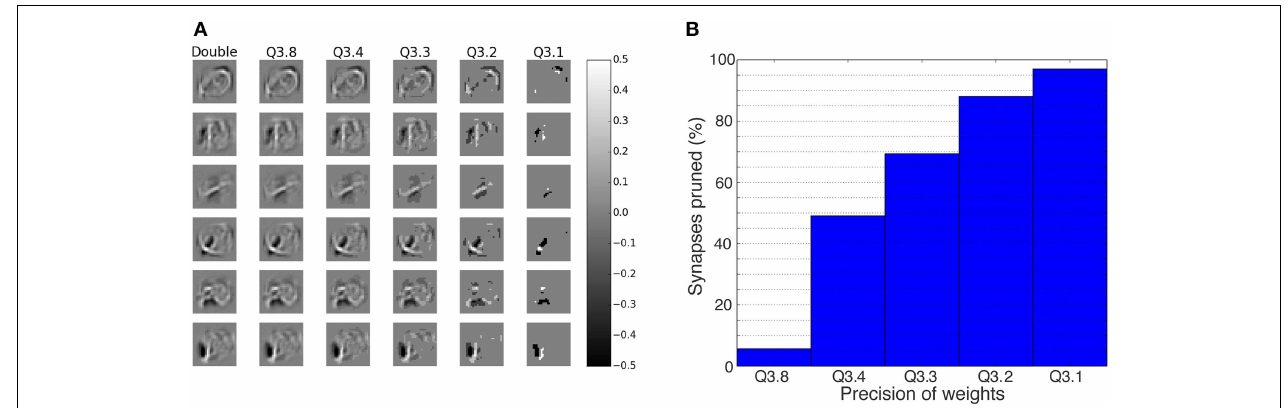
part and f the number of bits representing the fractional part. The effect of truncation of the synapses is visible to the eye for the case of f less. (B) Percentage of synapses from all layers that are set to zero due to the reduction in bit precision for the fractional part. For lower precisions, the majority of the synapses is set to zero and thus becomes